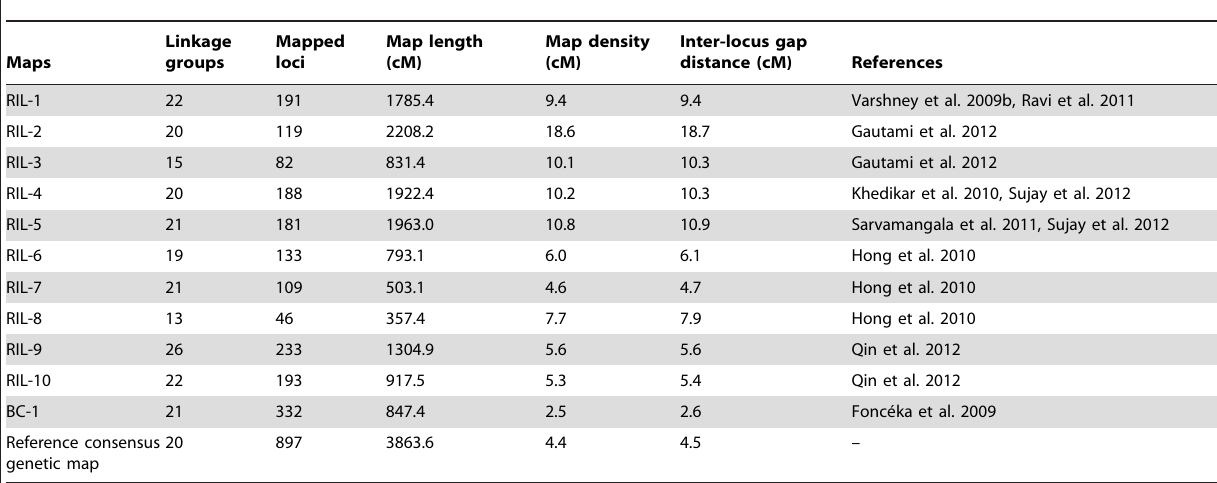
Table 2. Features of the component and reference consensus genetic